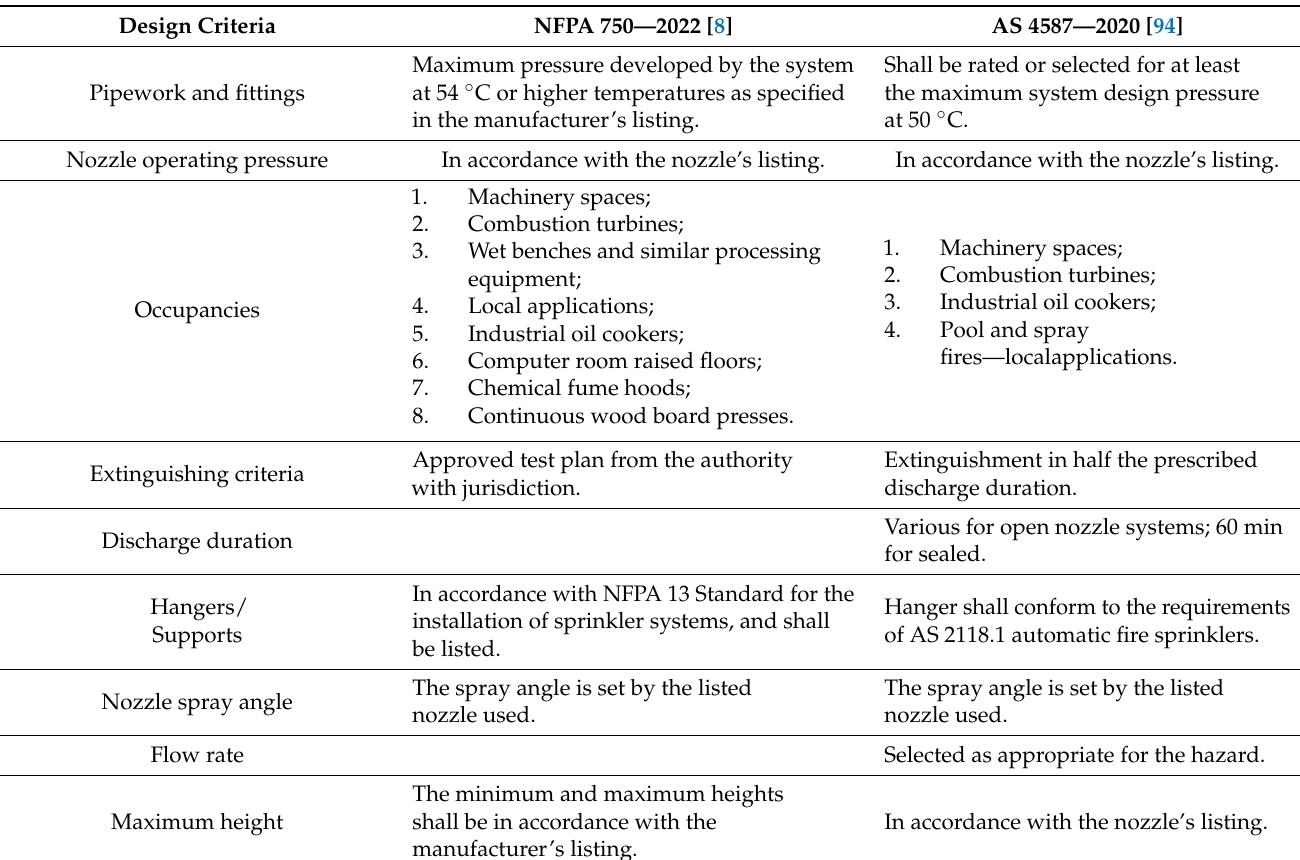
Table 4. Water mist design code